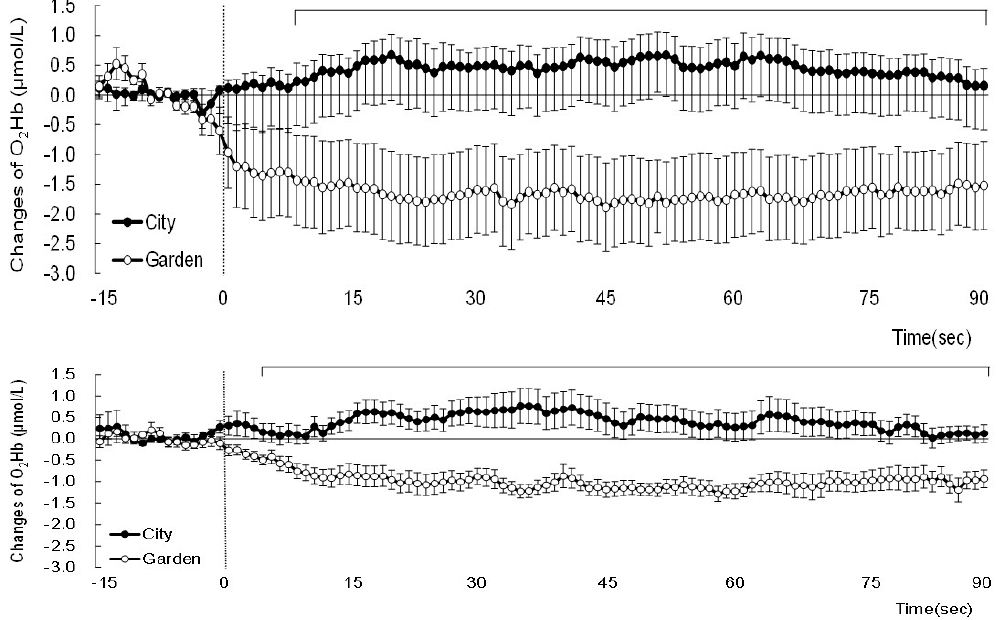
Figure 2. Changes in oxy-hemoglobin (O 2 Hb) in the left ( top ) and right ( bottom ) prefrontal cortex areas when observing city and garden landscapes. Mean ± standard error; N = 18; bar means significant difference.